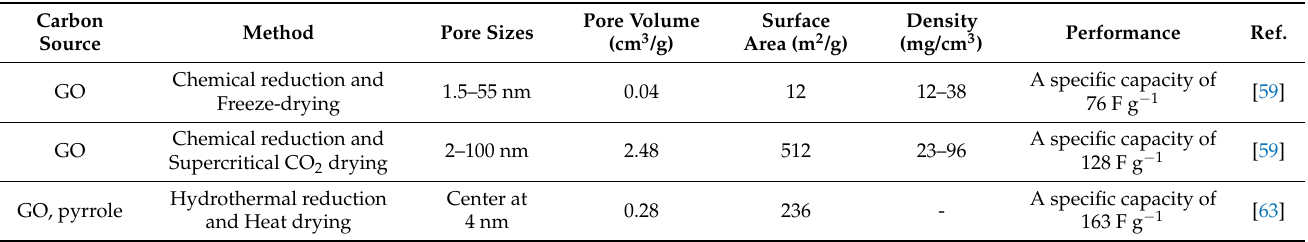
Table 1. Comparison of various 3D GBMs in terms of their synthesize methods, porous structures and performance for different